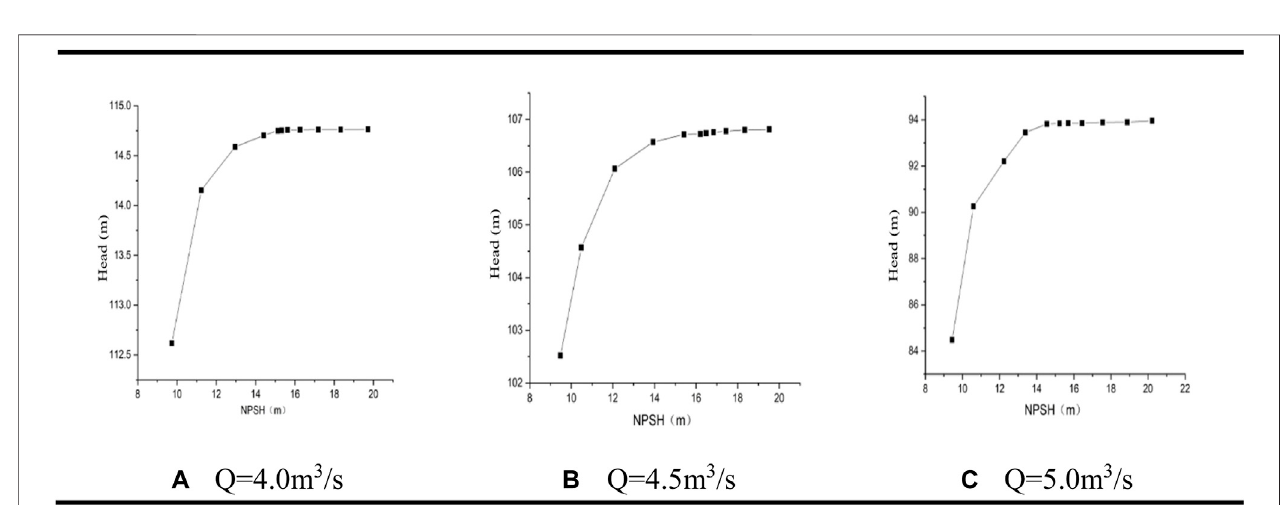
FIGURE 10 | Cavitation curves for different operating conditions. Q in represents different fl ow rates.